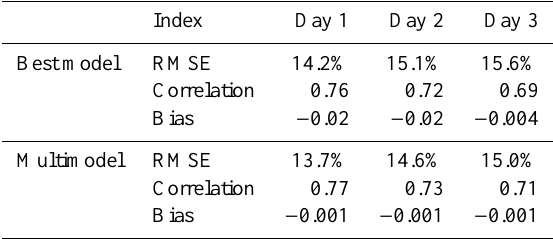
Table 1. Statistical indexes for hourly power forecast evaluation computed using measured data in Valledolmo wind farm. RMSE and BIAS are normalized by the nominal power (NP).